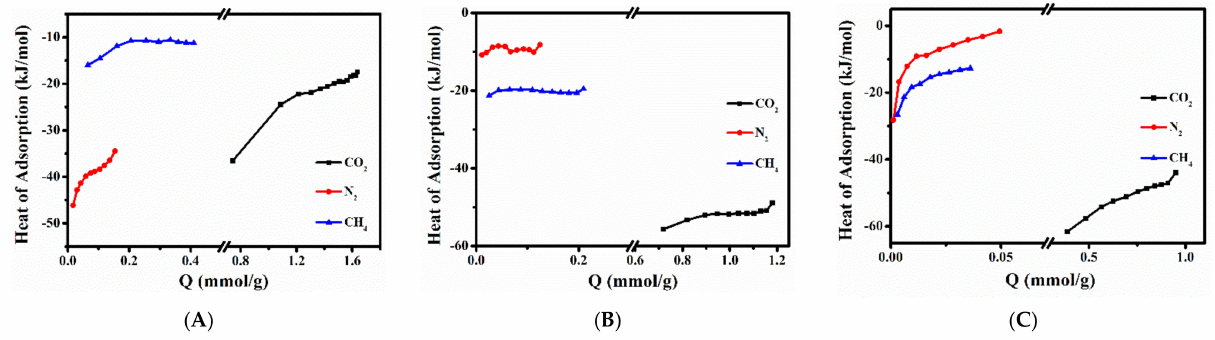
Figure 6. Adsorption heat of CO 2 , N 2 and CH 4 of (Na, K)–CP ( A ), Cs–6–CP ( B ), and Ca–4–CP ( C